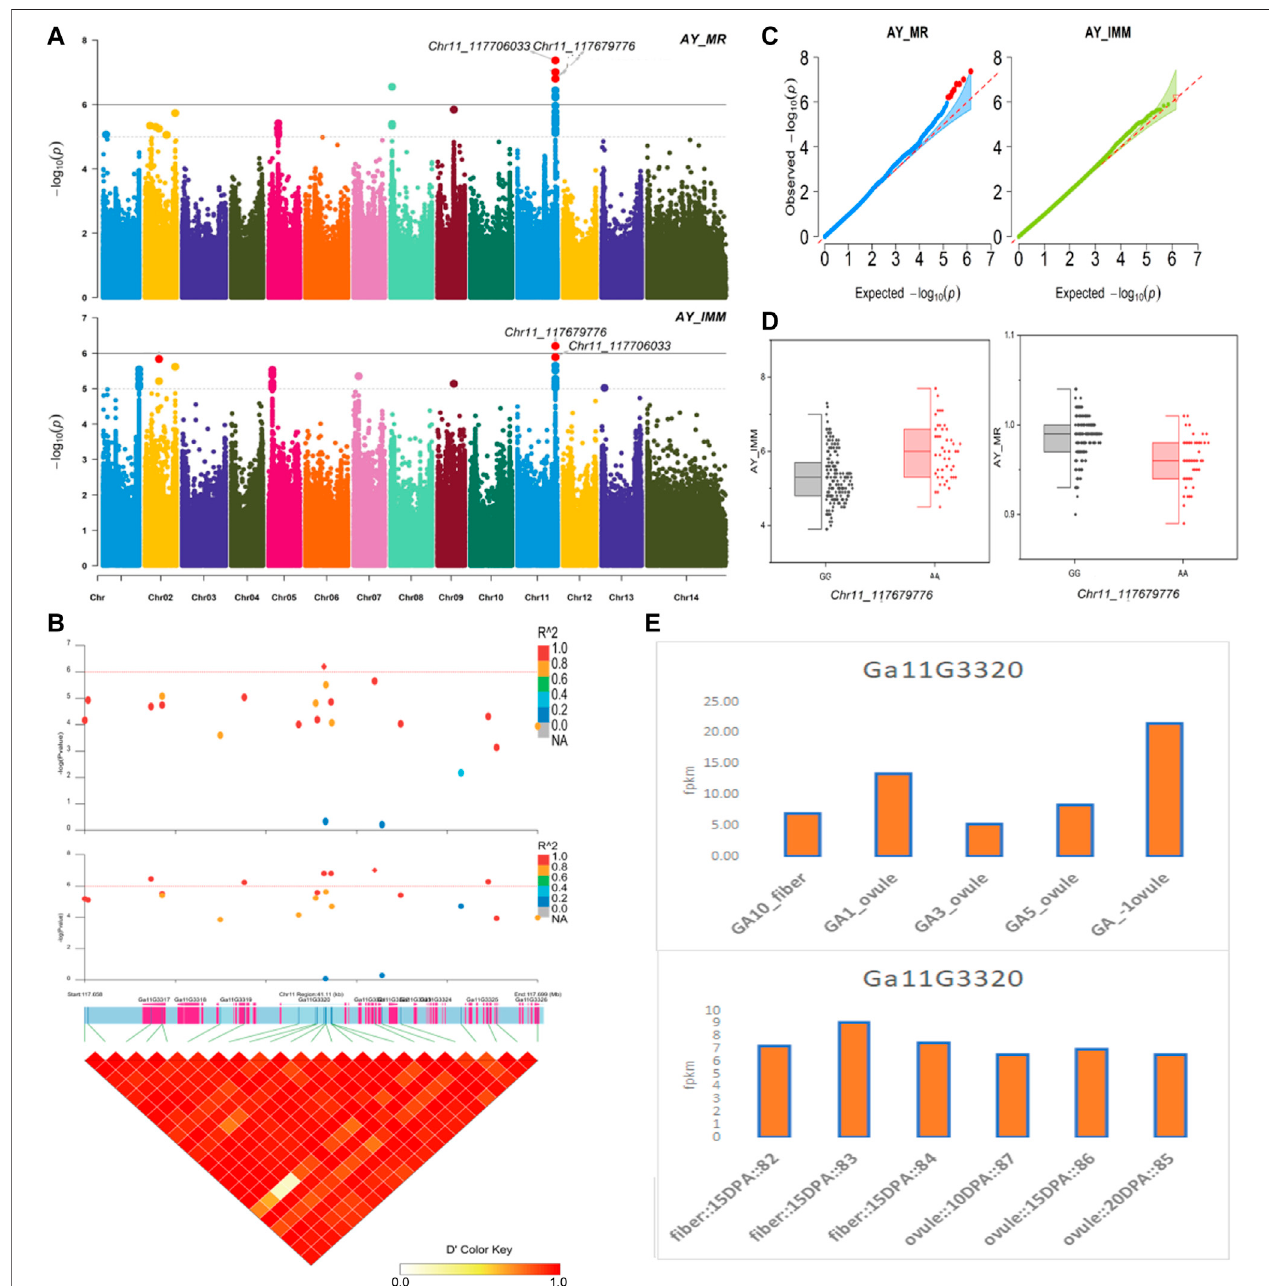
FIGURE 6 | Genome-wide association studies for Maturity in G. arboreum (A) Manhattan plots for Maturity related traits: AY_MR and AY_IMM; dotted-horizontal linein each plot illustrates signi fi cance threshold value kept at [ − log ( p ) > 6] (B) GWAS-LD block revealing haplotype region (41.11 kb) surrounding the exposed peak on chromosome Chr11 associated with Maturity related traits along with GWAS regional plot presenting key SNPs and nearby gene(s) in the region (C) Quantile-Quantile plots for Maturity related traits (D) Box plots demonstrating differences for Maturity related traits among two favorable haplotypes of SNP Chr11_117679776: AY_IMM (left) and Chr11_117679776:AY_MR (right) (E) Expression levels of representative annotated gene Ga11G3320 at different developmental stages of G . arboreum from two different sources.